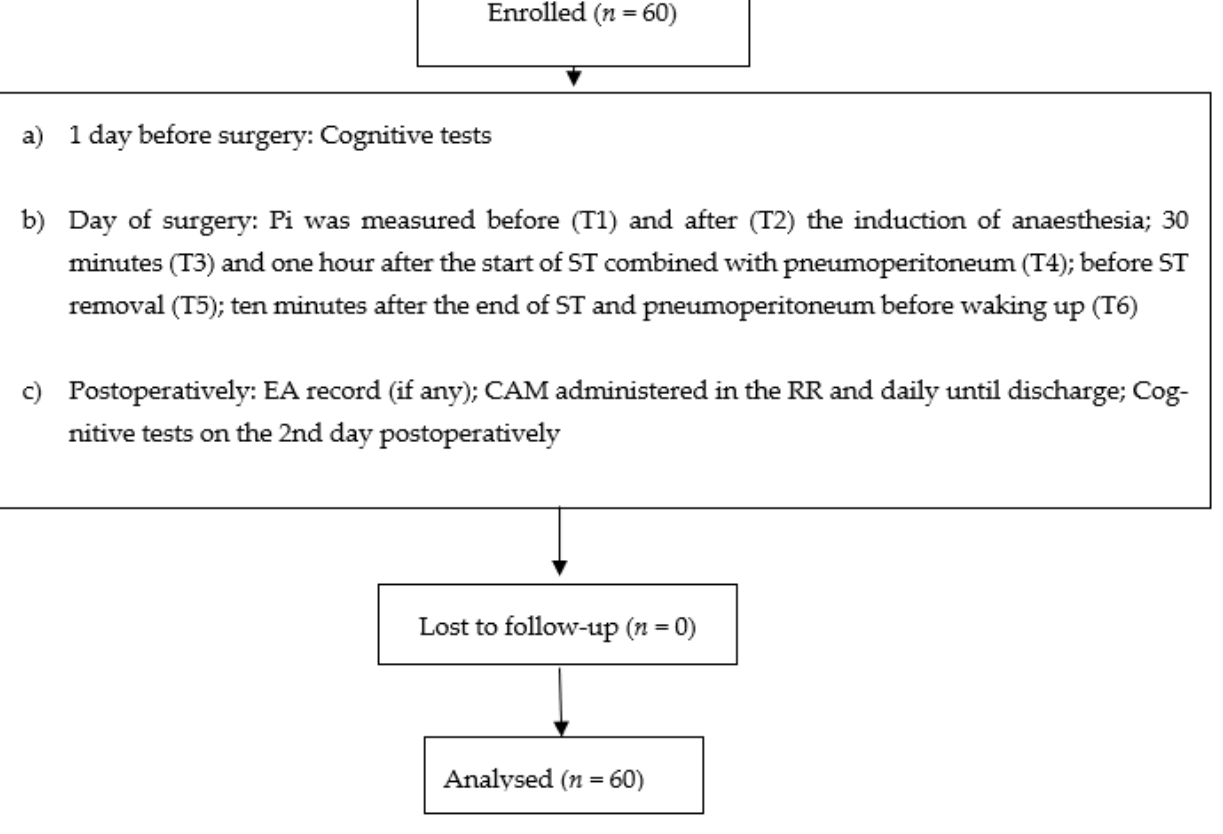
Figure 1. Study diagram flow with the description of study design. ST, steep Trendelenburg; Pi, pulsatility index; EA, emergence agitation; CAM, Confusion Assessment Method; RR, recovery room.